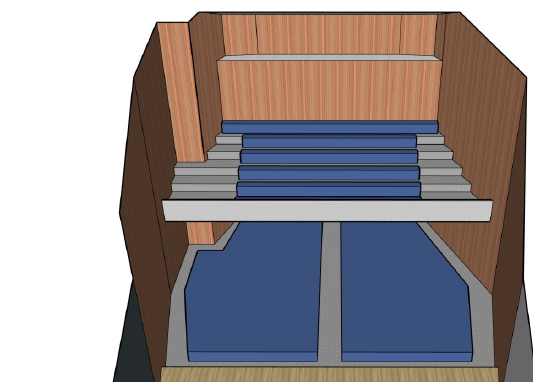
Figure 3. Comparison of the TMM and the experimental results, for two of the analyzed cases: ( a ) composition of samples: ( a1 ) perforated panel; ( a2 ) mineral wool; ( b ) configurations tested: ( b1 ) PP + MW + AG; ( b2 ) PP + AG + MW; ( c ) results calculated by the analytical approach and experimental data.